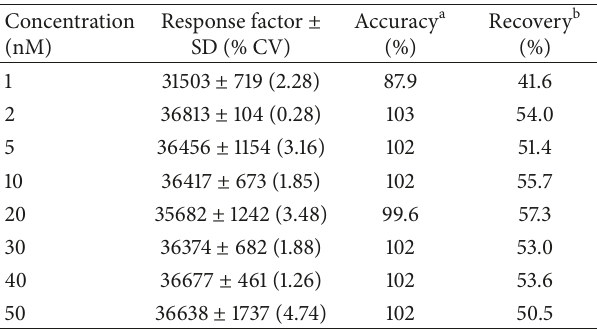
Table 2: Mean response factors, coefficients of variation (CV), accuracy, and recovery of pentosidine at various concentrations in human